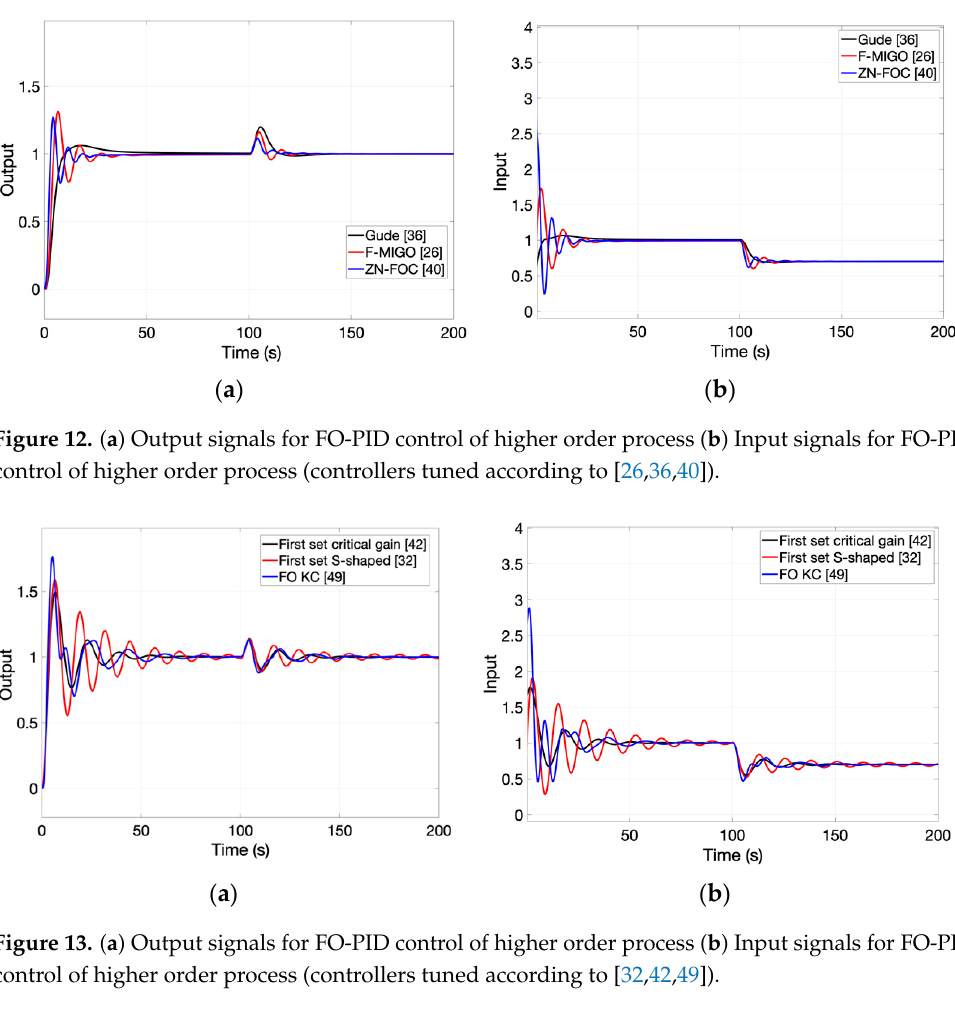
Table 5. Closed-loop results obtained with the FO-PID controller for the higher order process. Controller